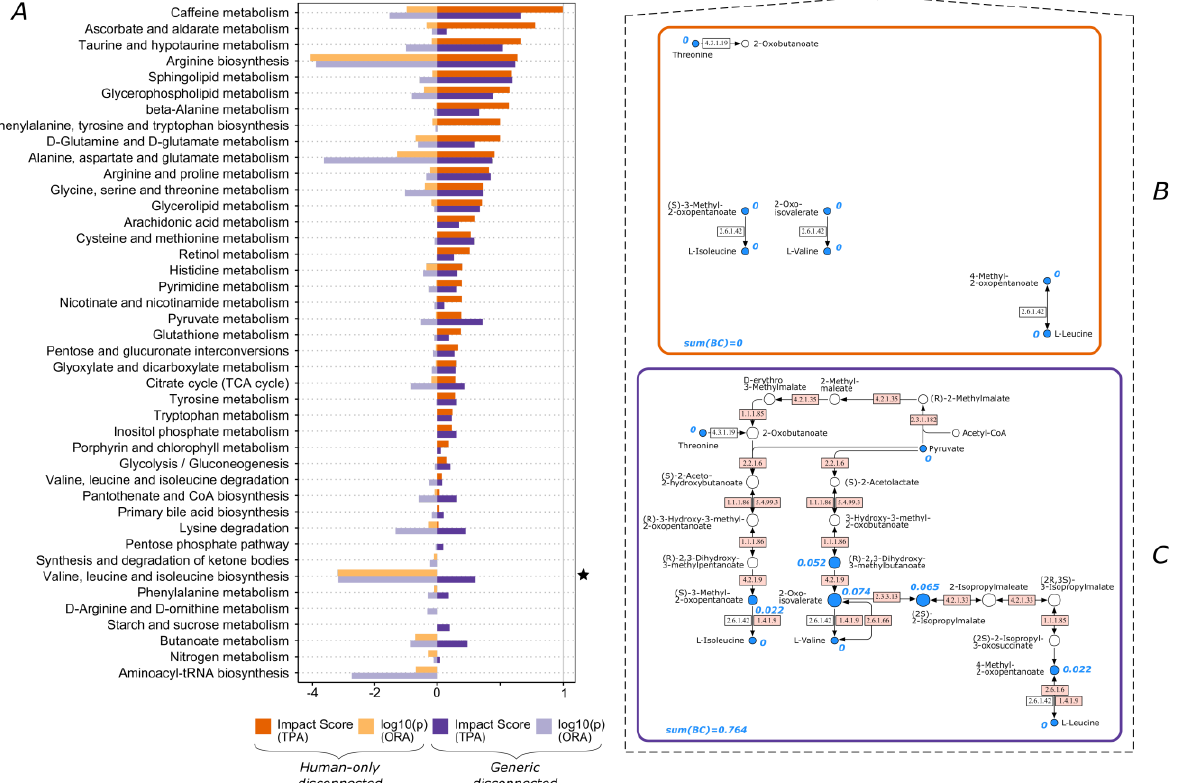
Figure 1. Pathway scoring comparison for dataset 1a. ( A ) TPA impact scores and ORA log10(p) values for all pathways (pathways exhibiting zero values in all cases are omitted). ★ “Valine, leucine and isoleucine biosynthesis” pathway for ( B ) human-only disconnected and ( C ) generic disconnected. Blue color denotes significant compounds in this dataset, blue values are the computed betweenness centrality scores for these nodes, sum(BC) is the sum of betweenness centrality scores for all the nodes of the pathway, and node size corresponds to the relevant betweenness centrality scores of the nodes within the pathway. White and pink boxes denote human native and non-human native enzymatic reactions, respectively.